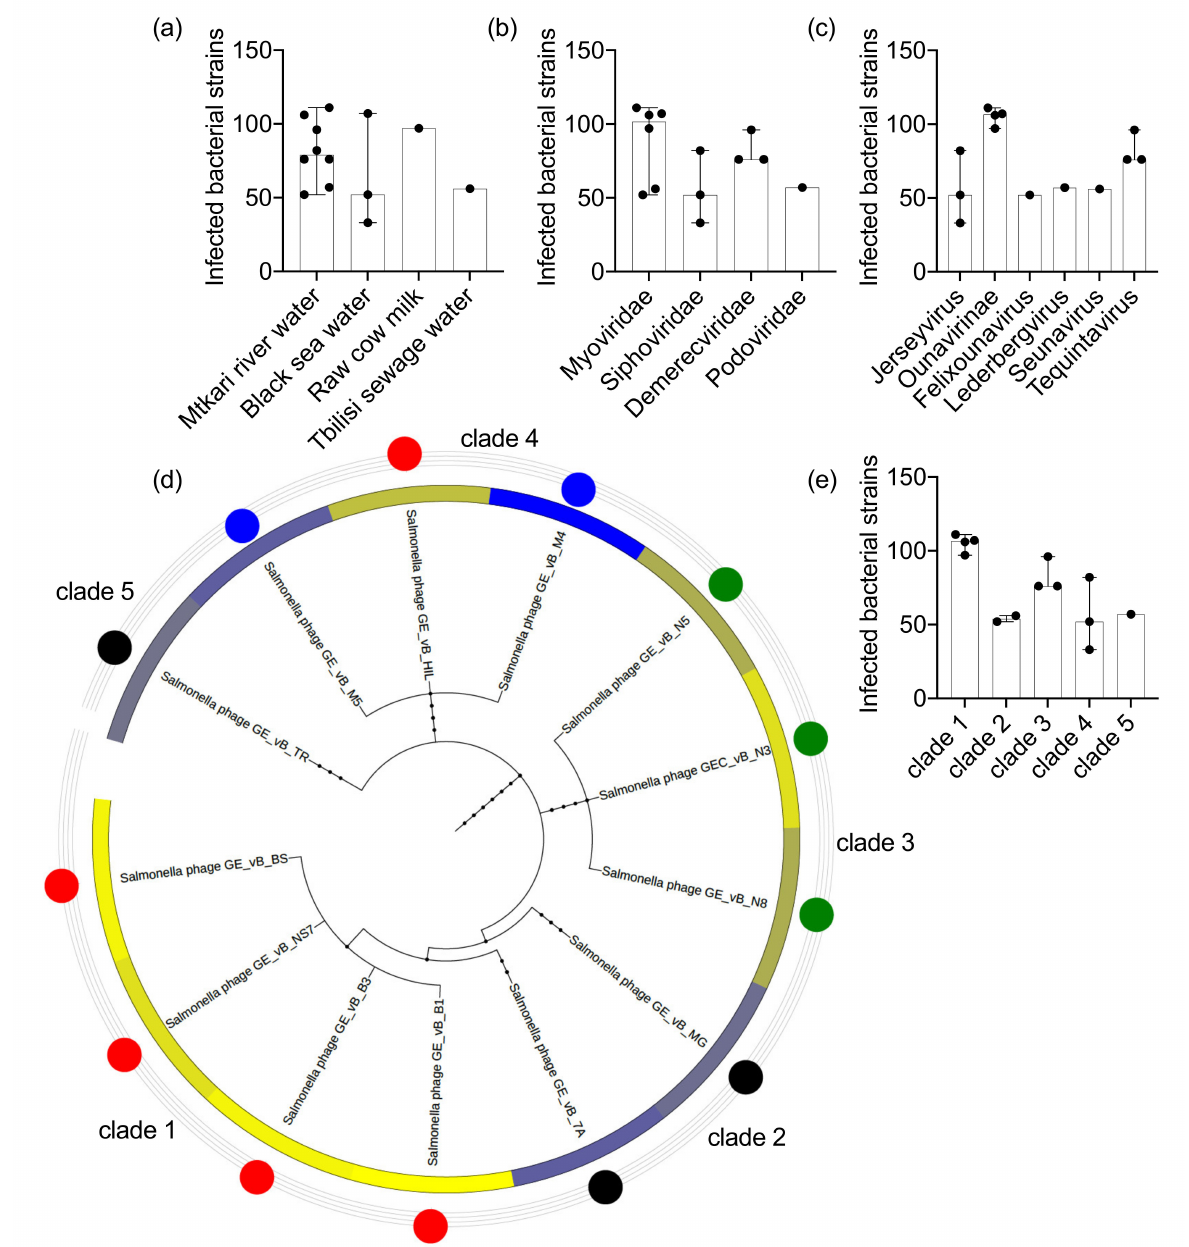
Figure 1. Salmonella phages target-range. The number of phage-infected Salmonella bacteria strains are presented according to the phage ( a ) environmental source, ( b ) taxonomic family, ( c ) taxonomic genus, ( d ) taxonomic lineage, and ( e ) taxonomic clade. The Salmonella phage taxonomic tree in ( e ) includes a circular heatmap which is analogous to the absolute number of infected bacterial strains (log 10 transformed) and the colored nodes represent the phage infection profile cluster that each phage was assigned to (see Figure 2); red: cluster 1, black: cluster 2, green: cluster 3, and blue: cluster